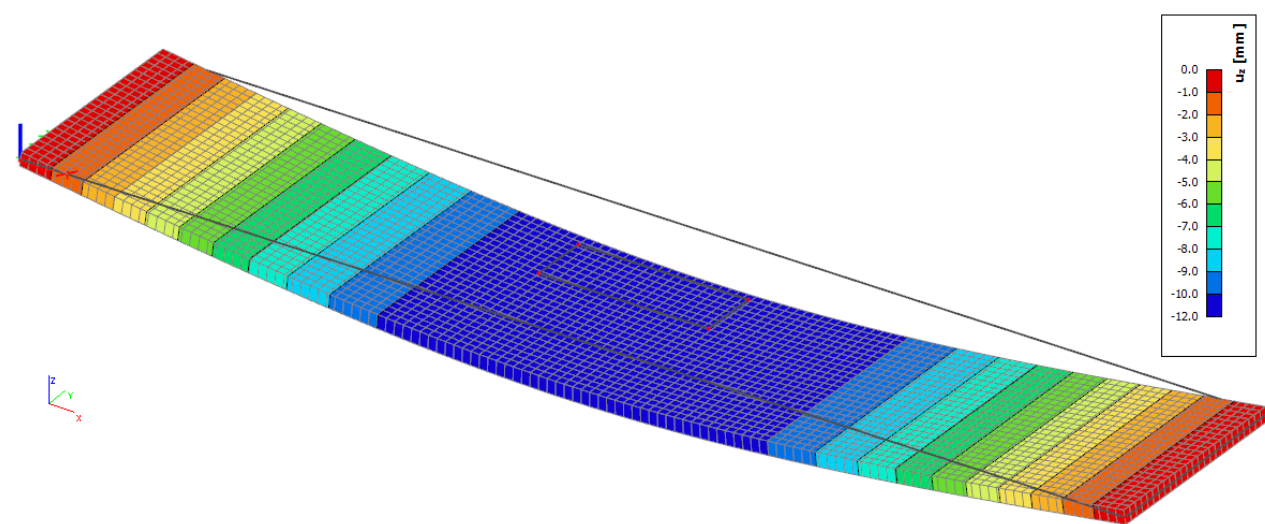
Figure 13. Numerically calculated displacement for the beam (Source: Own compilation).